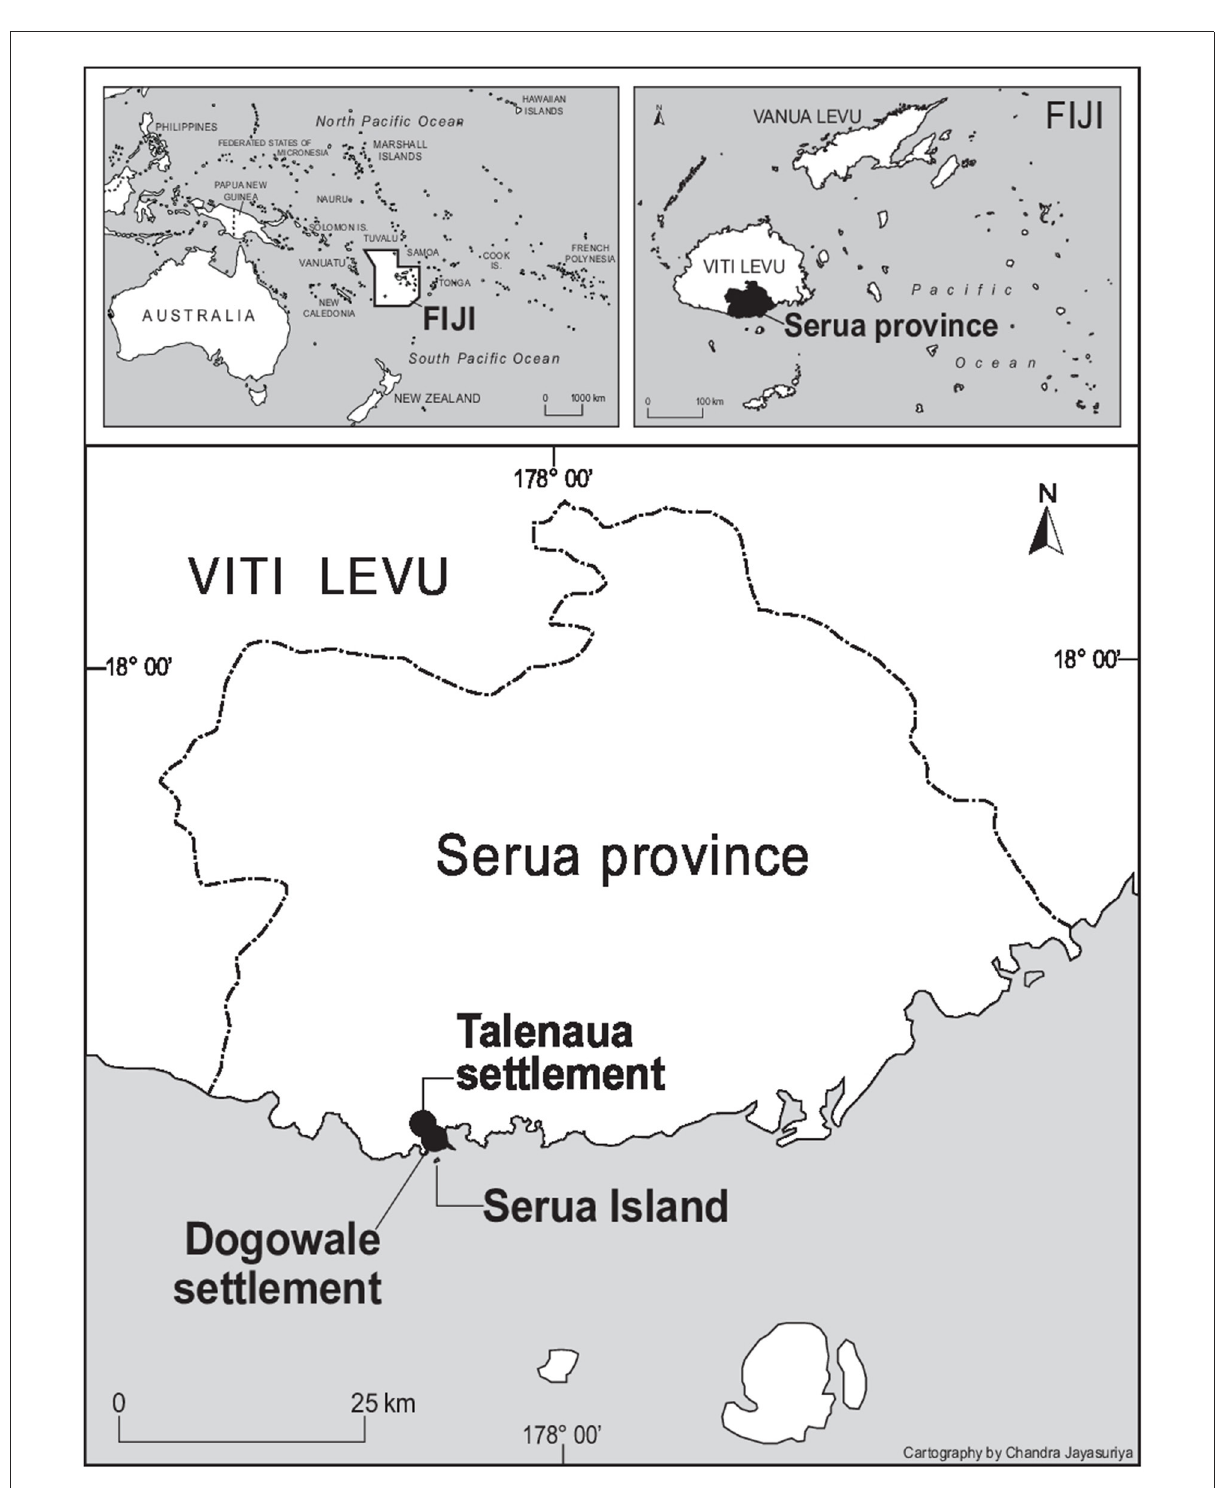
FIGURE1 Map identifying Serua Island, Dogowale, and Talenaua (prepared by Chandra